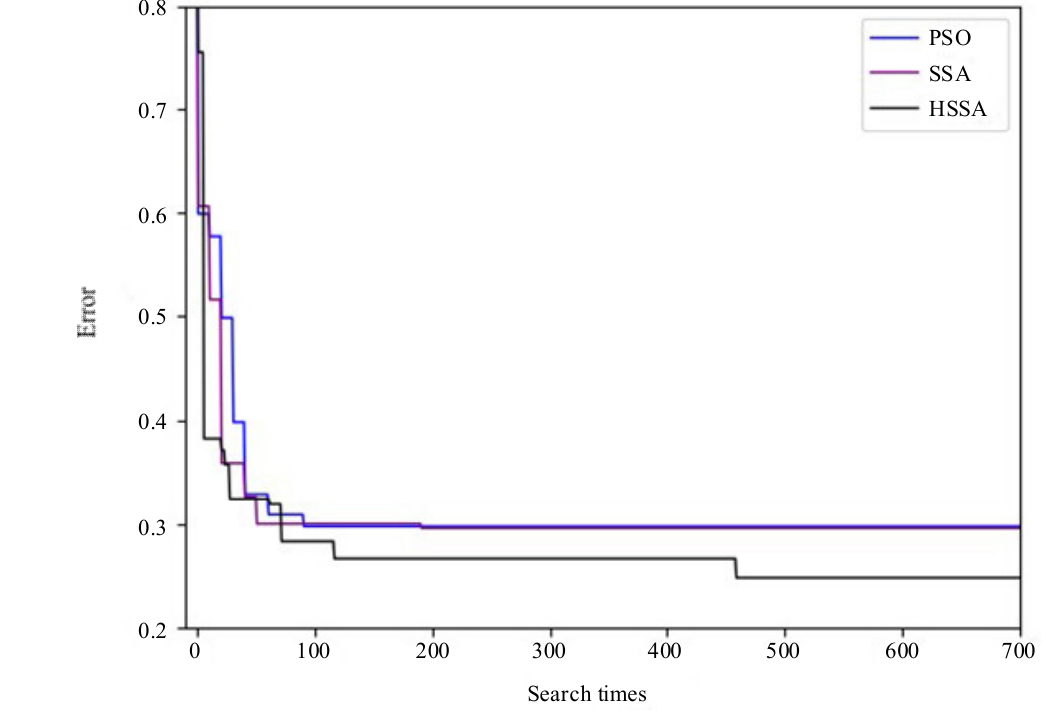
Figure 9. Results of the meaning verification experiment on Five Flowers.